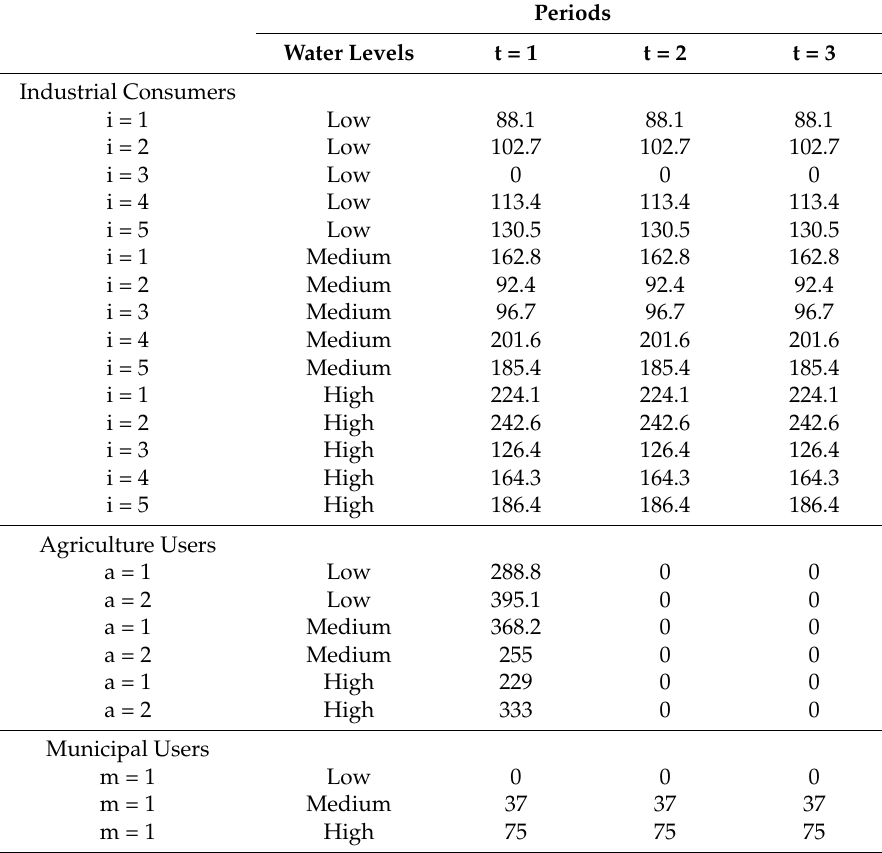
Table 6. Water shortage under 0.5 acceptance degree (10 6 m 3